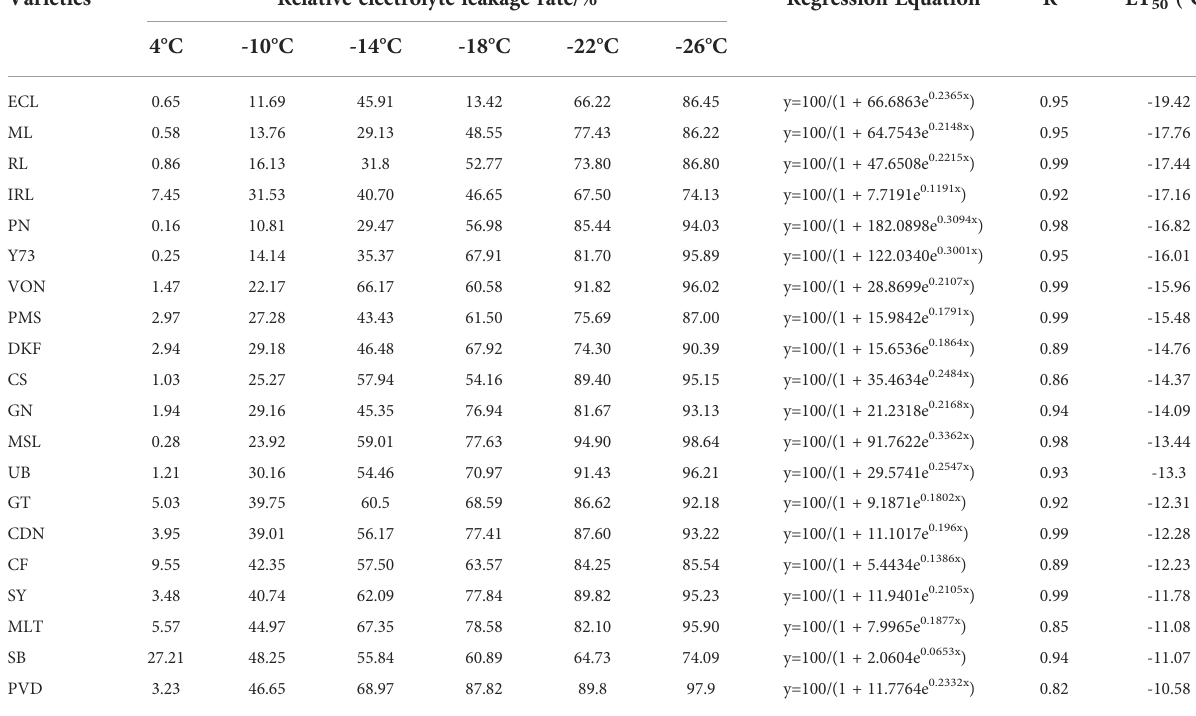
TABLE 1 Identi fi cation of cold resistance in 20 wine grape varieties based on